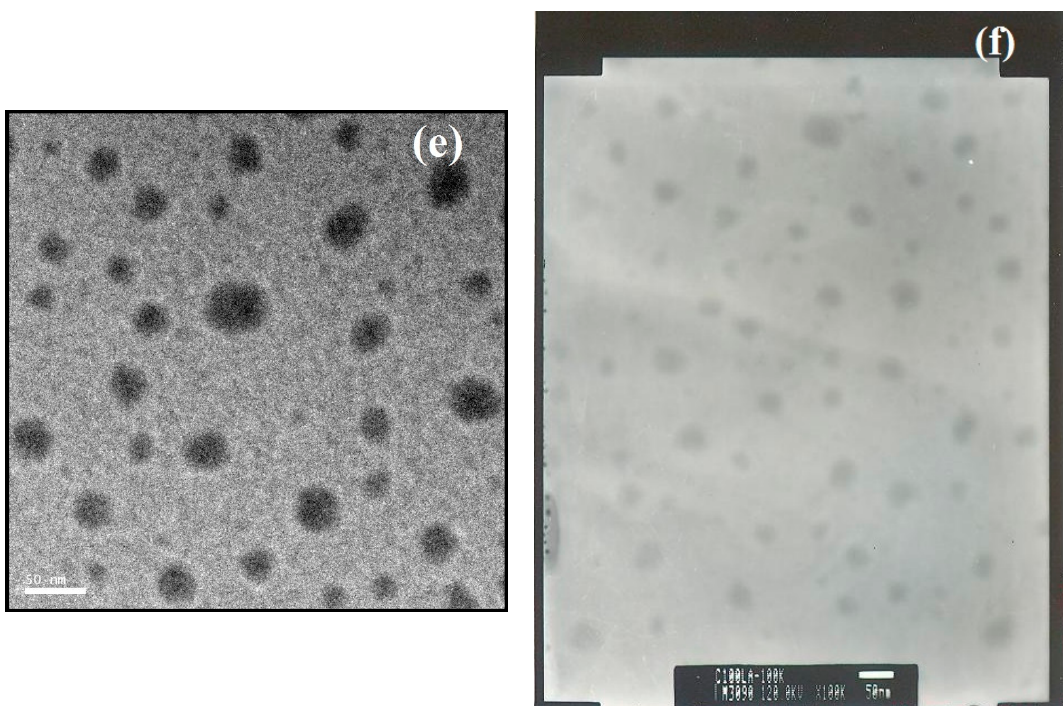
Figure 5. Transmission electron microscopy (TEM) images for the micelles without LA ( a – c ): MC 20 , MC 50, and MC 100 , respectively; the micelles loaded with LA ( d – f ): MC 20 LA, MC 50 LA, and MC 100 LA, respectively. The scale bar is 50 nm except for Figure 5d in which it is 200 nm.